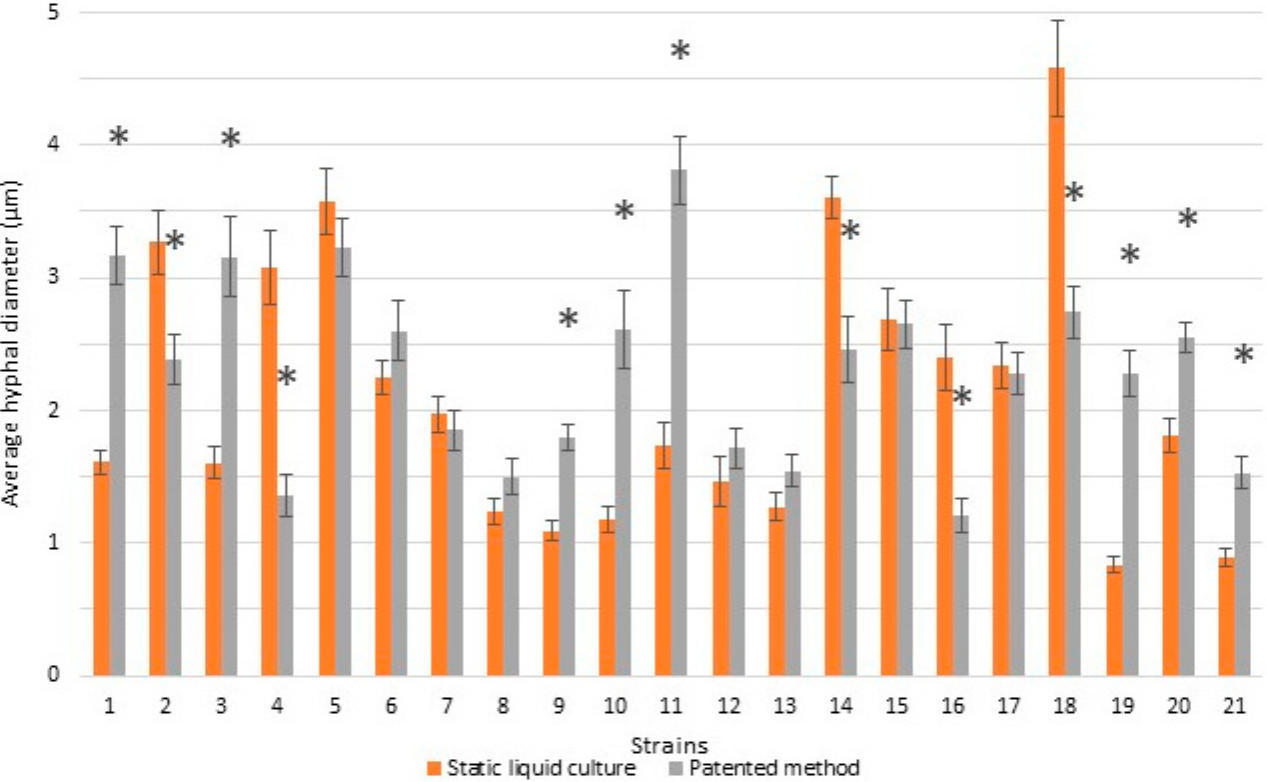
Figure 14. Average ± standard error of mycelium hyphal diameter obtained in liquid static culture and by patented method. Significantly different diameters are marked by * based on Wilcoxon’s test (* p -value < 0.05).